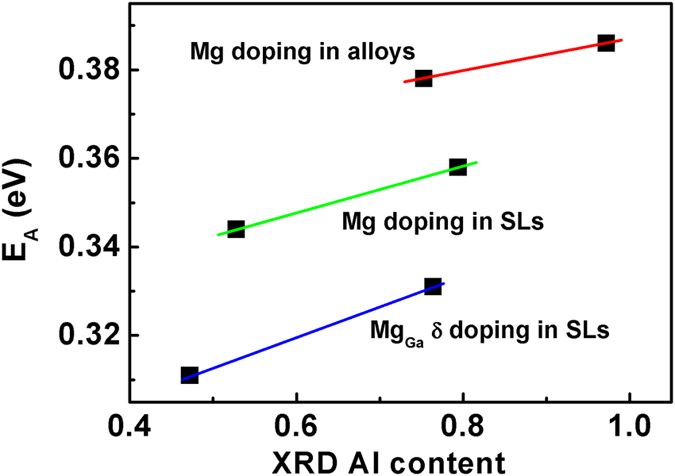
The dependence of EA on Al composition in AlxGa1−xN with three doping methods.